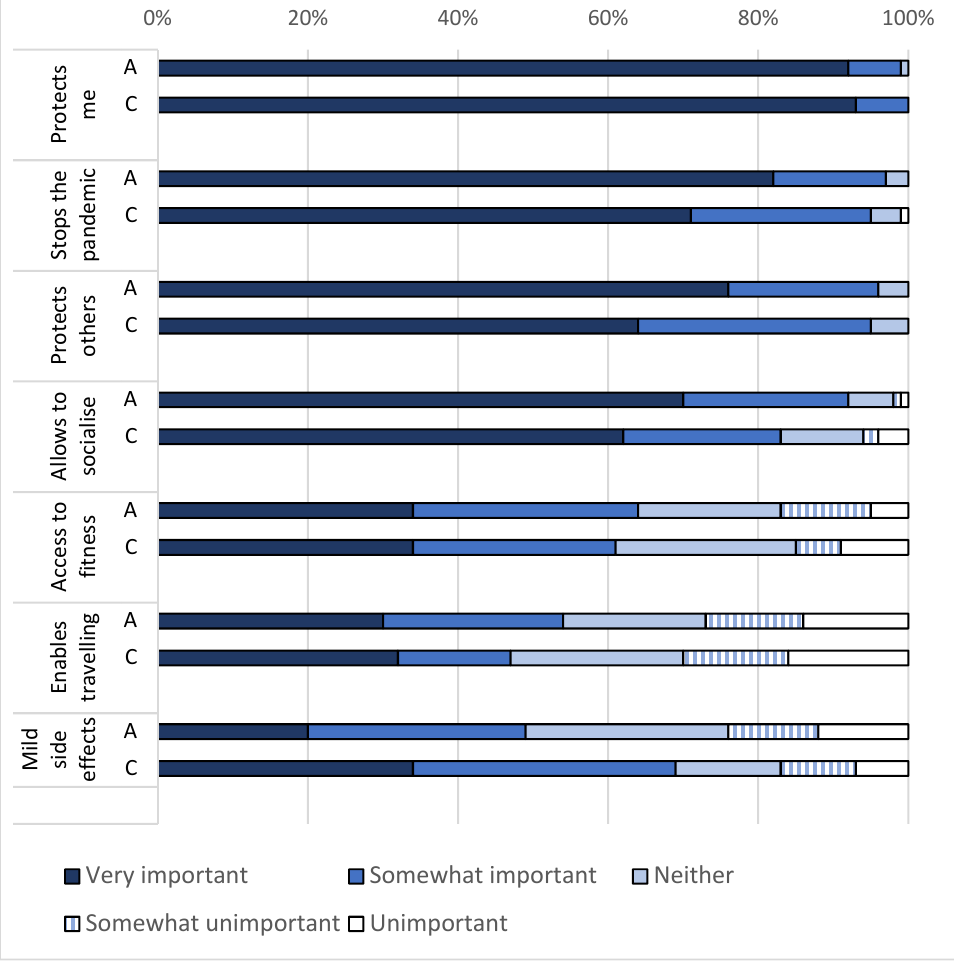
Figure 1. Reasons for getting vaccinated among participants who already got vaccinated or wanted to get vaccinated among adults ( n = 272) and children and adolescents ( n = 94). Responses rated from very important to unimportant. (COVID-PCD study, May 2021). Abbreviations: A = adults aged 18 years or above; C = children and adolescents below 18 years.